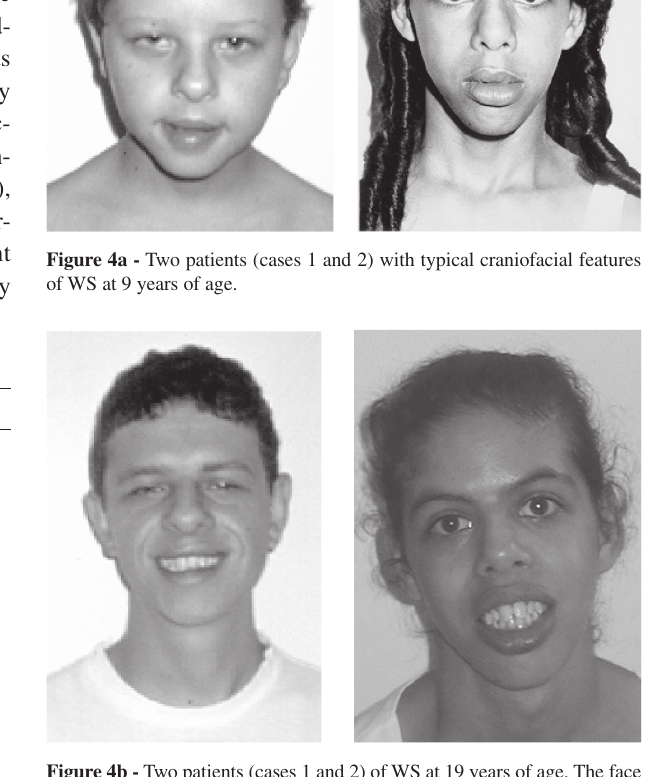
Figure 4b - Two patients (cases 1 and 2) of WS at 19 years of age. The face has become more elongated, the supraorbital ridges are more prominent, and the lips have thickened. Both patients showed premature wrinkling of the